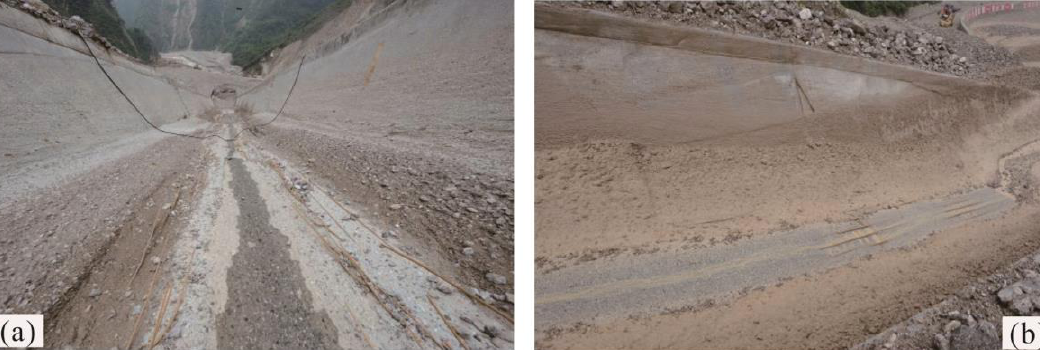
Figure 12. Development of abrasion at the bottom of the upper and lower sections of the ED section.